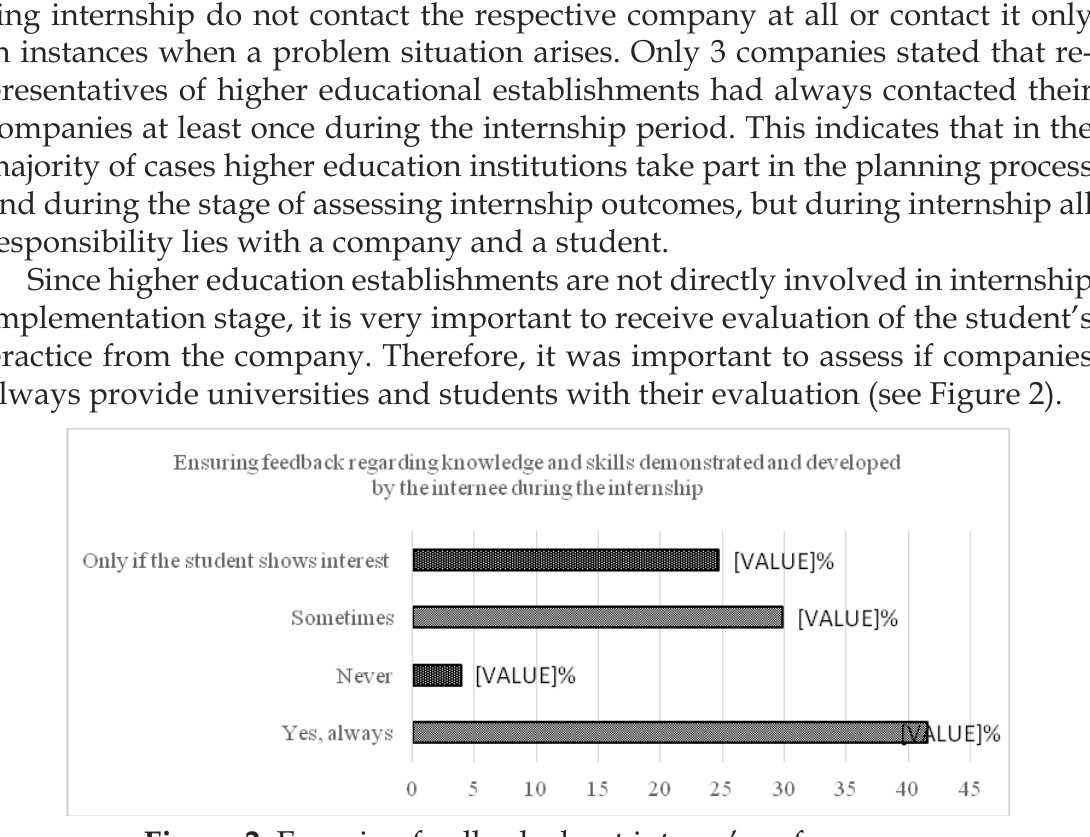
Figure 2. Ensuring feedback about interns’